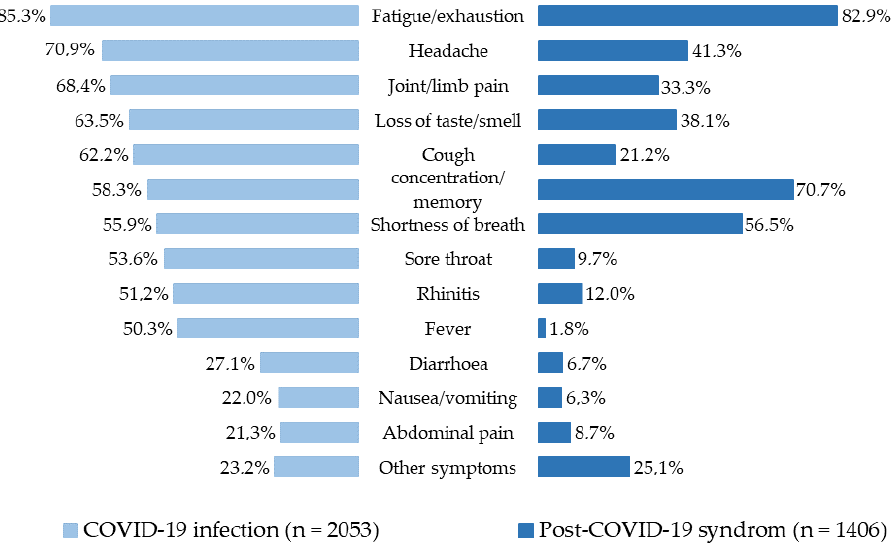
Figure 3. Acute symptoms and symptoms persisting longer than three months after COVID-19 (PCS) in health workers.